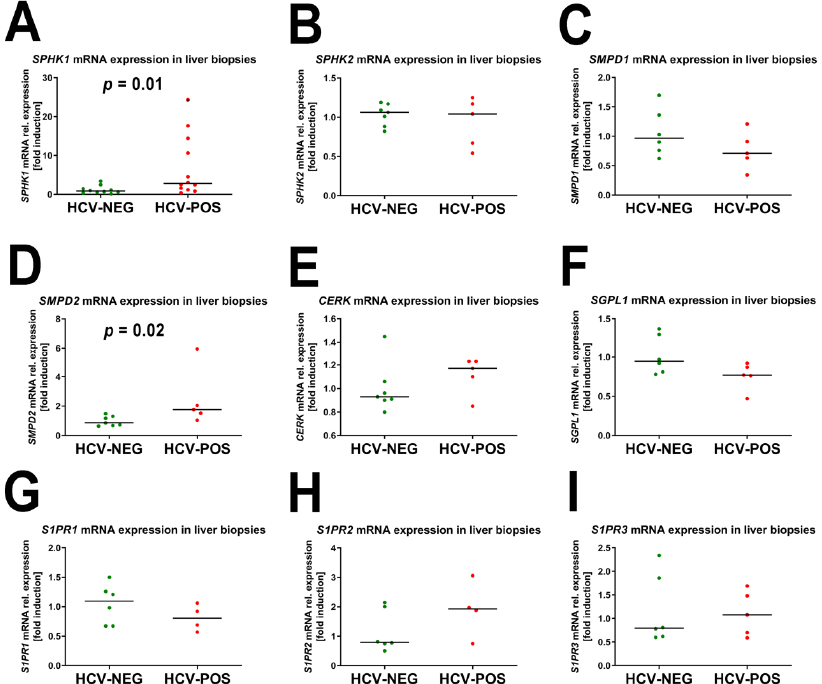
Figure 6. mRNA expression of genes involved in sphingolipid metabolism. ( A ) Sphingosine kinase 1 ( SPHK1 );( B ) Sphingosine kinase 2 ( SPHK2 ); ( C ) Sphingomyelin phosphodiesterase 1 ( SMPD1 ); ( D ) Sphingomyelin phosphodiesterase 2 ( SMPD2 ); ( E ) Ceramide kinase ( CERK ); ( F ) Sphingosine 1-phosphate lyase ( SGPL1 ); ( G ) Sphingosine 1-phosphate receptor 1 ( S1PR1 ); ( H ) Sphingosine 1-phosphate receptor 2 ( S1PR2 ); ( I ) Sphingosine 1-phosphate receptor 3 ( S1PR3 ).